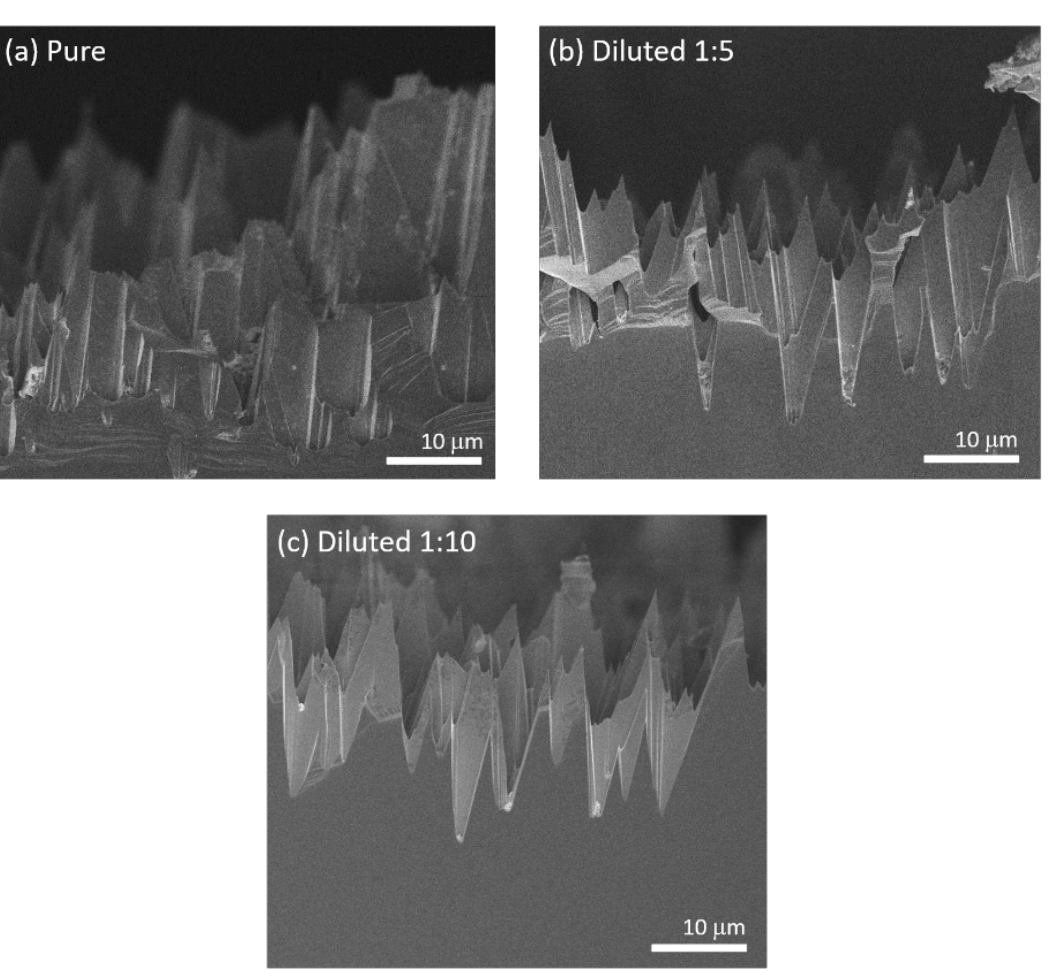
Figure 4. Cross-sectional SEM micrographs of the (111)B etched surface after 30 min treatment in pure aqua regia ( a ), and in aqua regia diluted in water with proportion 1:5 ( b ) and 1:10 ( c ).